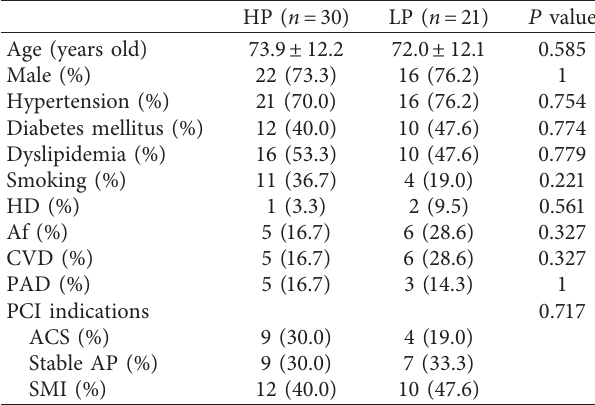
Table 1: Baseline clinical characteristics of the study